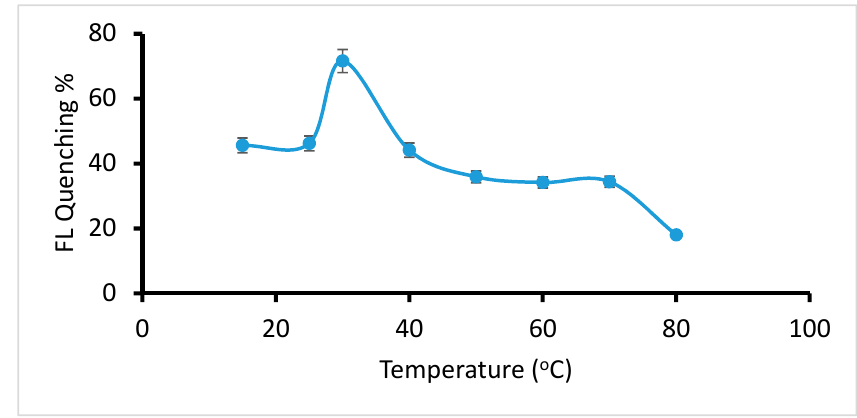
Figure 4. Effect of incubation temperature on reaction of QDs with verapamil HCl.